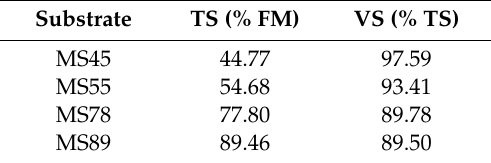
Table 1. The initial parameters of the tested material (maize straws) used for fermentation.